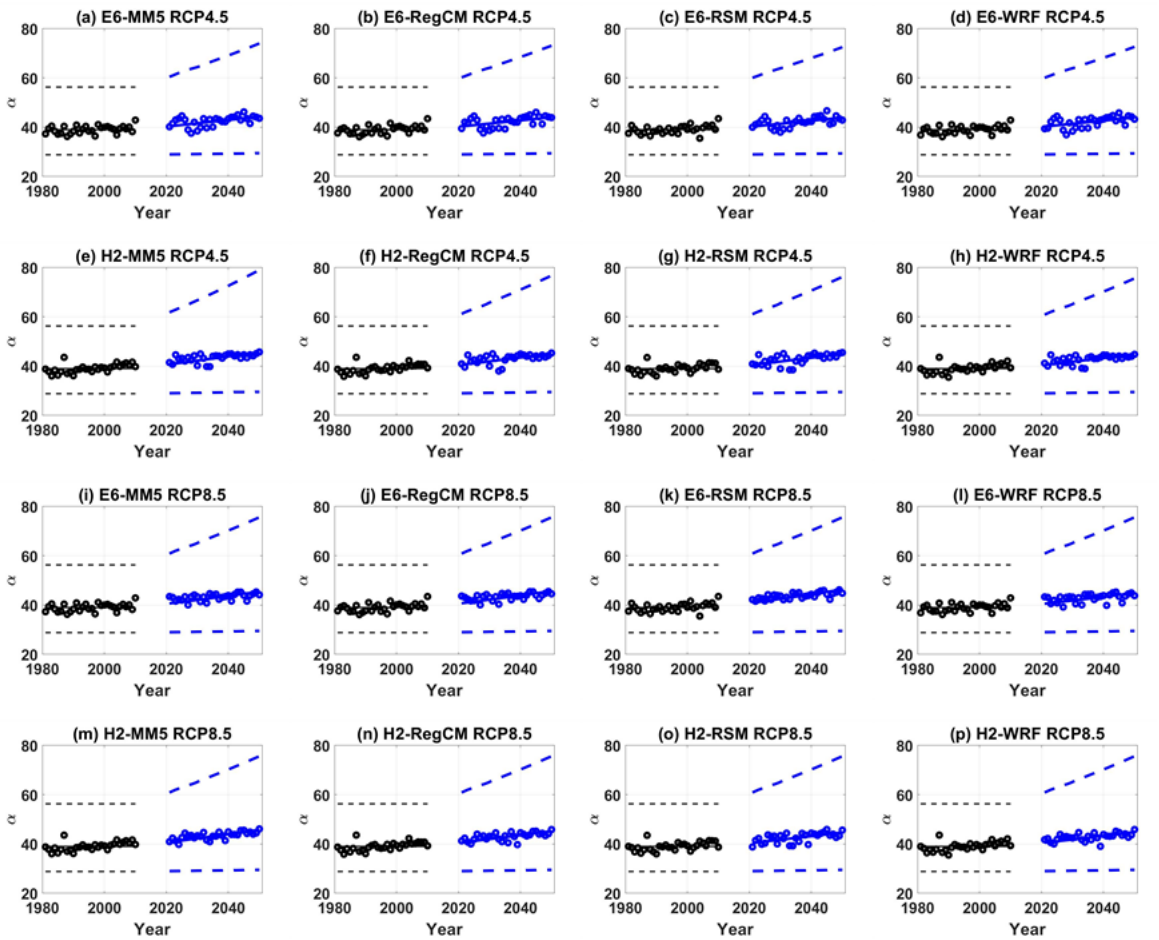
Figure 5. Time evolution of the scale parameter for the non-stationary model n 2 at the Cheonan site. The solid line is the ensemble average of the scale parameters, and the dotted line is the 95% confidence interval derived from the posterior distribution. The circle is a scale parameter corresponding to the case of directly reflecting the anomaly of the yearly DPT by present and future years. The black represents the present, and the blue represents the future.